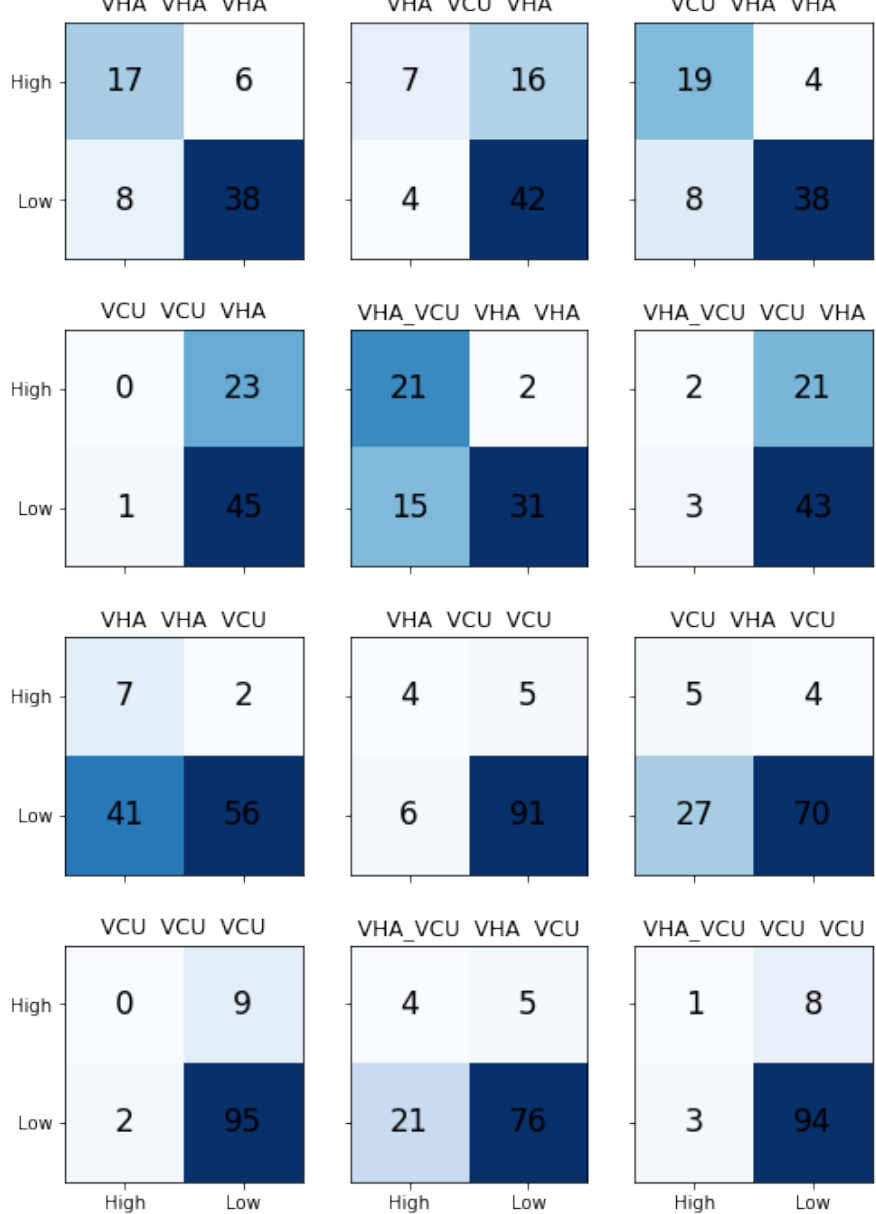
Figure 7. Transfer Learning Results: Confusion Matrix for each model in test dataset. Title in each confusion matrix indicates the respective model. Top two rows (six models) is for VHA testset and bottom two rows (six models) for VCU testset. Diagonal indicates the correctly predicted class